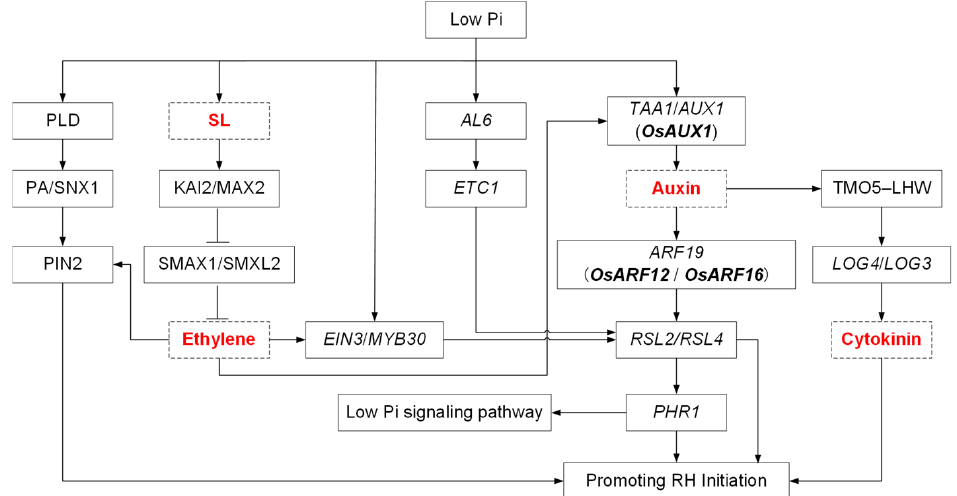
Figure 3. The molecular regulatory pathway of Pi starvation-induced RH growth in Arabidopsis and rice. Arrows indicate a positive regulation, and blunt arrows represent negative regulation. Names in bold represent genes from rice. The hormones are highlighted in red.